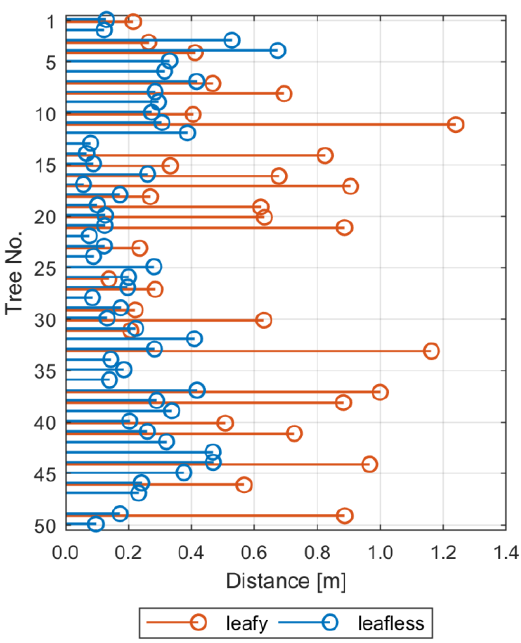
Figure 5. Distance between the measured and detected stem center location for the leafy and leafless test periods Due to the unsatisfactory results of tree trunk identification Figure 4. Tree identification results for a) leafy and b) leafless during the leafy period, validation of stem diameter season; tree location is in the center of a red circle; black dots determination was performed only for the leafless period. Figure represent identified trunk points 6 presents the comparison of stem diameters obtained with PCA- based approach and from circle fitting with diameters calculated from circumferences measured directly in the field for the 50 test trees. Both methods were able to determine a diameter for all test trees, but with significantly different accuracy. The RMSE of differences between diameters determined from LiDAR with circle fitting and measured in the field was 0.06 m, with the largest difference of 0.28 m for tree no. 14. For 42 trees the diameter error was below 0.05 m and for another 4 trees it